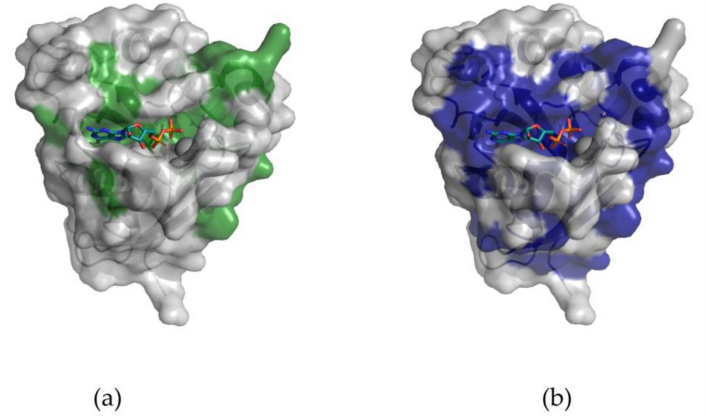
Figure 1. Evolutionary conservation of Rab GTPase proteins. ( a ) The surface representation of Rab1a crystal structure (green) from Homo sapiens (PDB ID: 4FML) shows residues that are fully conserved across all human Rab proteins (PDB IDs: 3TKL, 6IF2, 5LPM, 2IL1, 1X3S, 1Z0F, 2A5J, 2P5S, 6HUF, 1YZT, 2FG5, 1Z22, 4QXA, 2F7S, 20CB, 3TS0); ( b ) Residues that are 100% conserved across Rab1a proteins from multiple species (mouse, rat, wolf, human, pig, thale cress, slime mold, great pond snail) are shown in